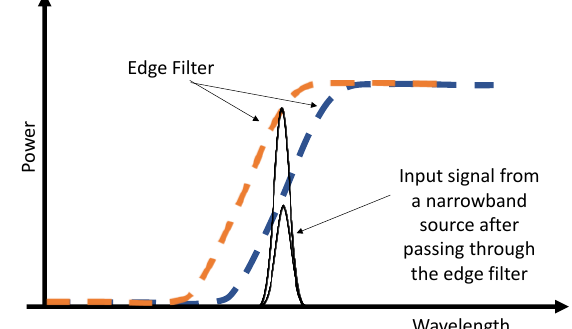
Fig. 1. Power fluctuation of a laser source as it passes through an edge